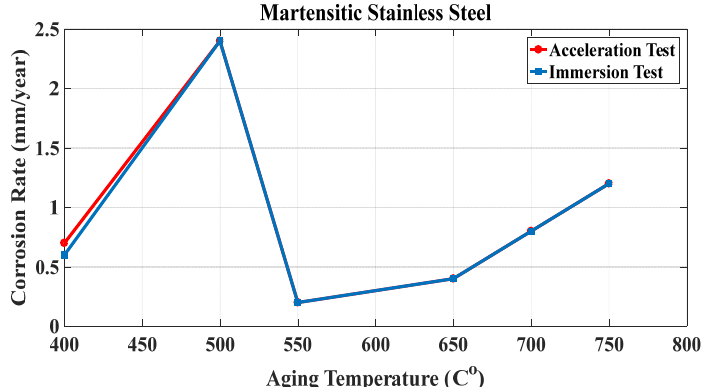
Fig. 12. Effect of 5-hour aging temperature on chemical corrosion rate due to acceleration test (dynamic voltage test) and immersion test